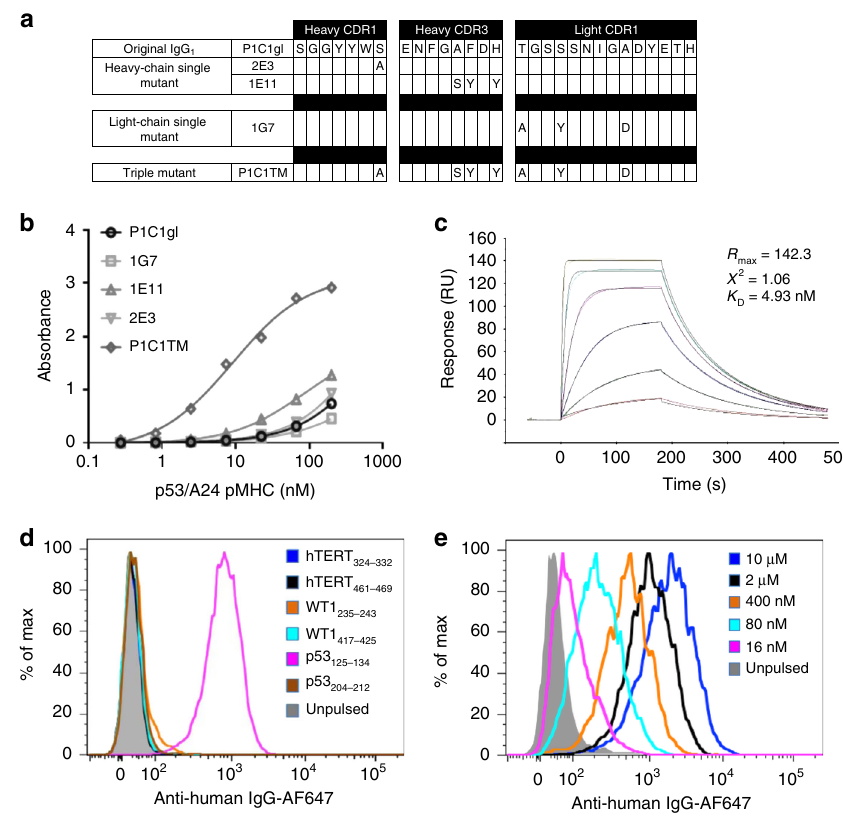
Fig. 2 Af fi nity maturation of TCRL antibody P1C1. a CDR1 and 3 of the heavy chain and CDR1 of the light chain of the original P1C1gl clone and the af fi nity- matured clones are shown. Mutants 2E3, 1E11 and 1G7 were identi fi ed by off-rate comparison for improved binding from the heavy-chain CDR1, CDR3 and light-chain CDR1 libraries, respectively. Mutations were sequenced and combined in a single triple mutant, P1C1TM. b Comparison of the binding af fi nities of the germline sequence converted P1C1 (P1C1gl), individual mutants and triple mutant (P1C1TM) was done by ELISA. Soluble biotinylated recombinant p53 125 – 134 /A24 pMHCs were incubated with immobilized antibodies and detected with HRP-conjugated streptavidin. c Binding kinetics of P1C1TM was analysed by surface plasmon resonance. Soluble recombinant p53 125 – 134 /A24 pMHCs was fl owed over P1C1TM antibodies captured on an anti-human IgG- coated sensor chip at a range of concentrations between 200 and 2 nM. Binding speci fi city and avidity of P1C1TM to p53 125 – 134 /A24 pMHCs on cells were evaluated with SaoS2 cells pulsed with either a panel of six known A24 peptides, including p53 125 – 134 ( d ) or a range of p53 125 – 134 peptide concentrations ( e ). Data are representative of two or more